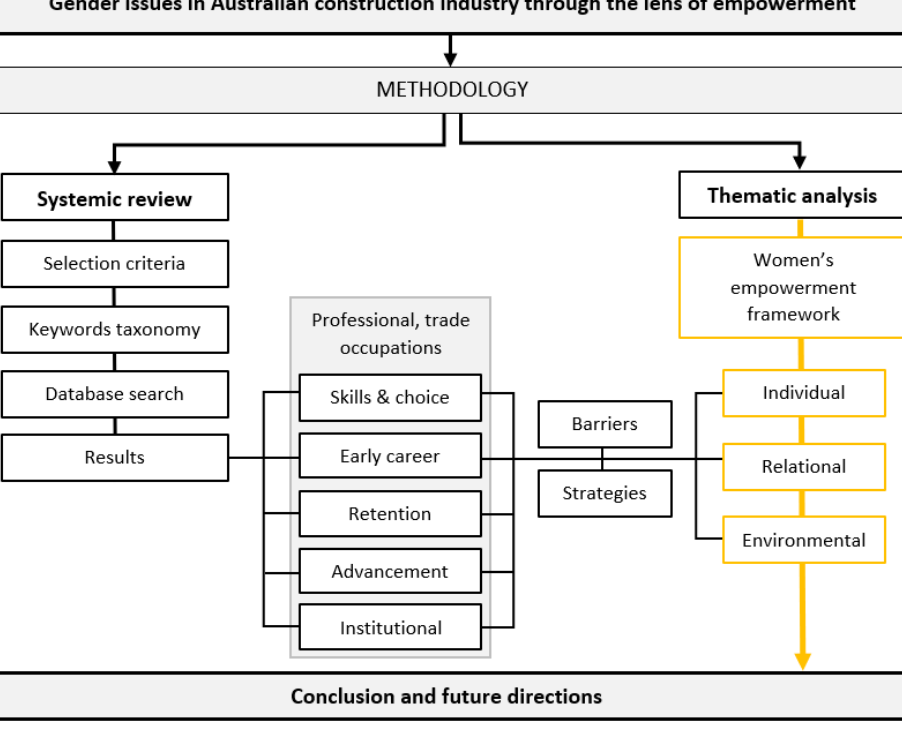
Figure 1. Methodological approach to the analysis of women’s empowerment in construction in Australia.